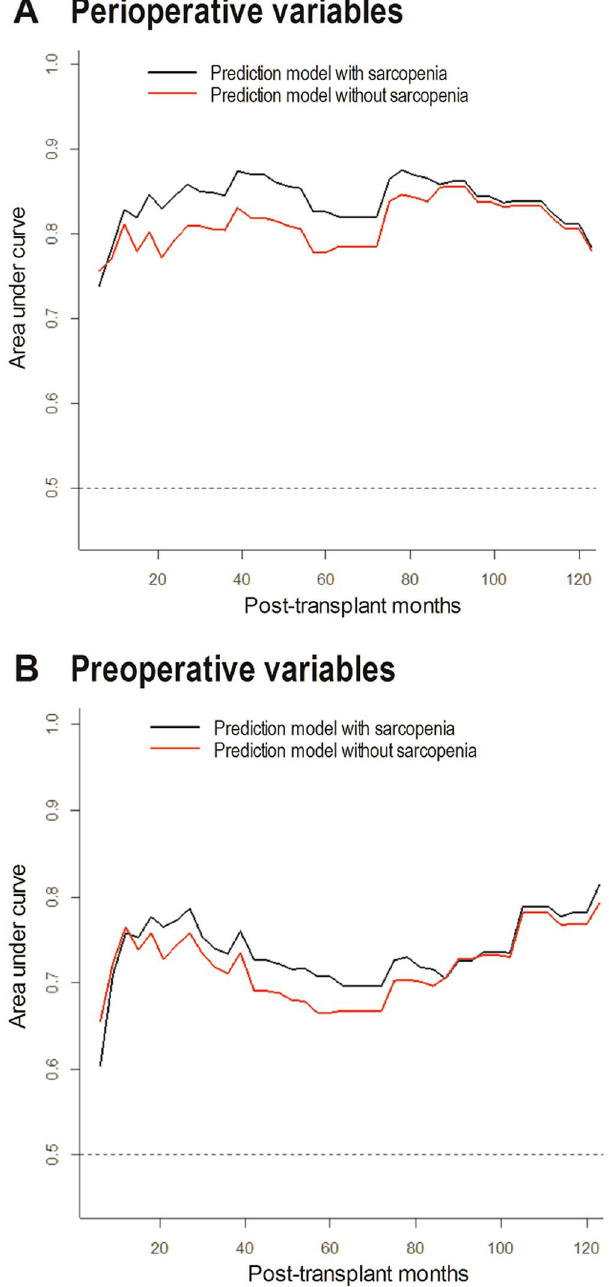
Figure 4. C-index of the prediction model for hepatocellular carcinoma recurrence. ( A ) sarcopenia plus alpha- fetoprotein and microvascular invasion vs. alpha-fetoprotein and microvascular invasion without sarcopenia and ( B ) sarcopenia plus alpha-fetoprotein vs. alpha-fetoprotein